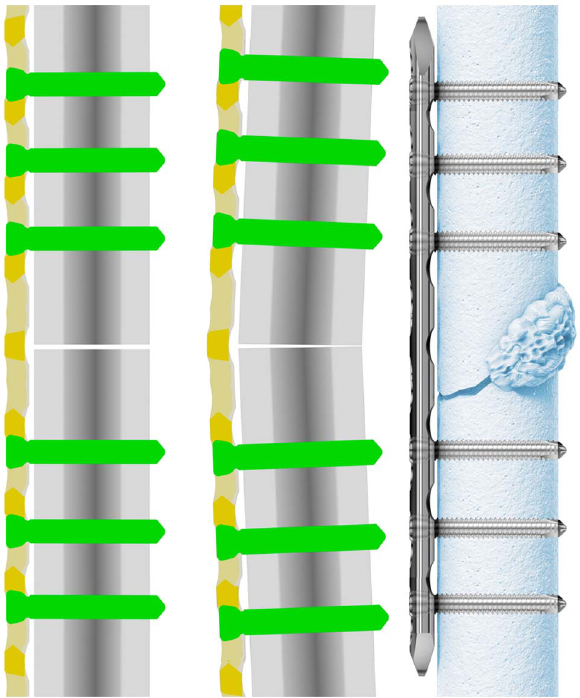
Figure 1. Osteosynthesis with Locking Head Screws without and with axial load and callus formation only at the trans cortex.